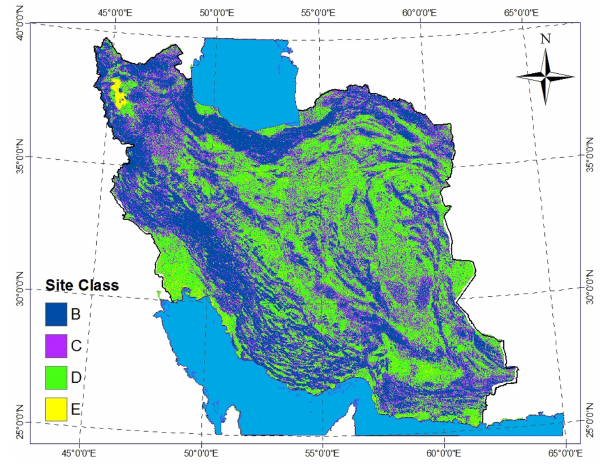
Figure 4. Produced soil classification map of Iran, using Allen and Wald (2009) method.